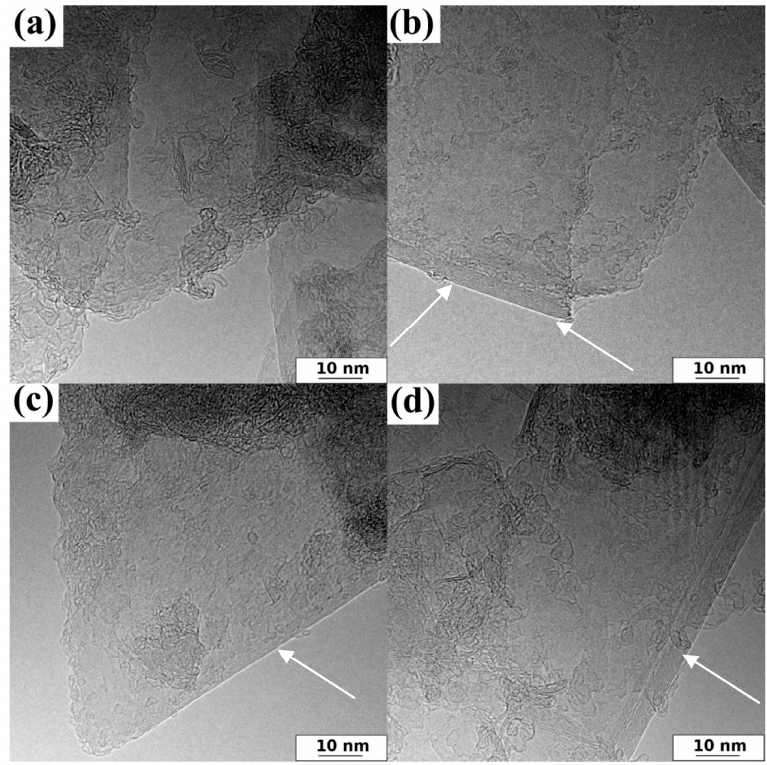
Figure 2. Representative HRTEM images of obtained samples: ( a ) GF_Na_600 sample, ( b ) GF_Na_700 sample, ( c ) GF_Na_800 sample, and ( d ) GF_Na_900 sample, (white arrows on the image ( b – d ) showing pure and thin sheets).